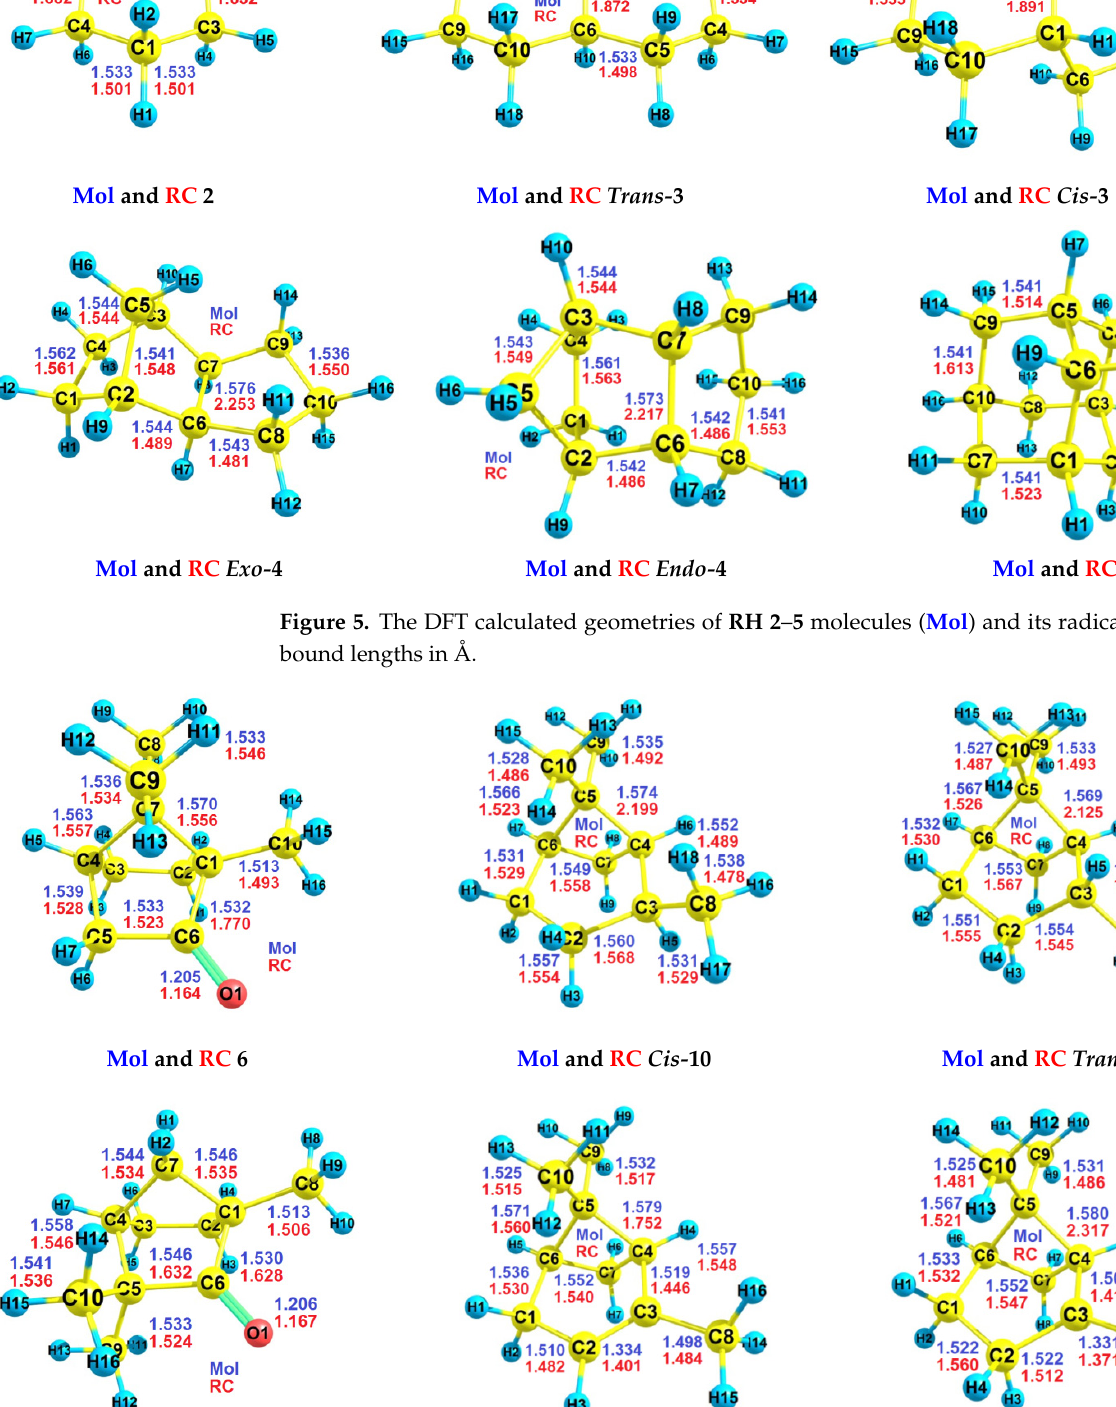
Figure 6. The DFT calculated geometries of RH 6 , 10 , 13 –1 5 molecules ( Mol ) and its radical cations ( RC ), bound lengths in Å.